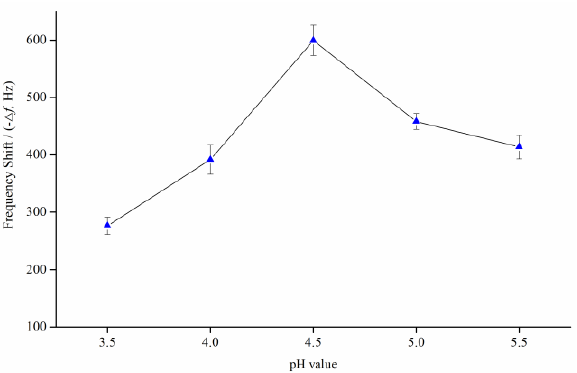
Figure 2. The resulting frequency shift during the immobilization of the ZEN–OVA conjugate at different pH